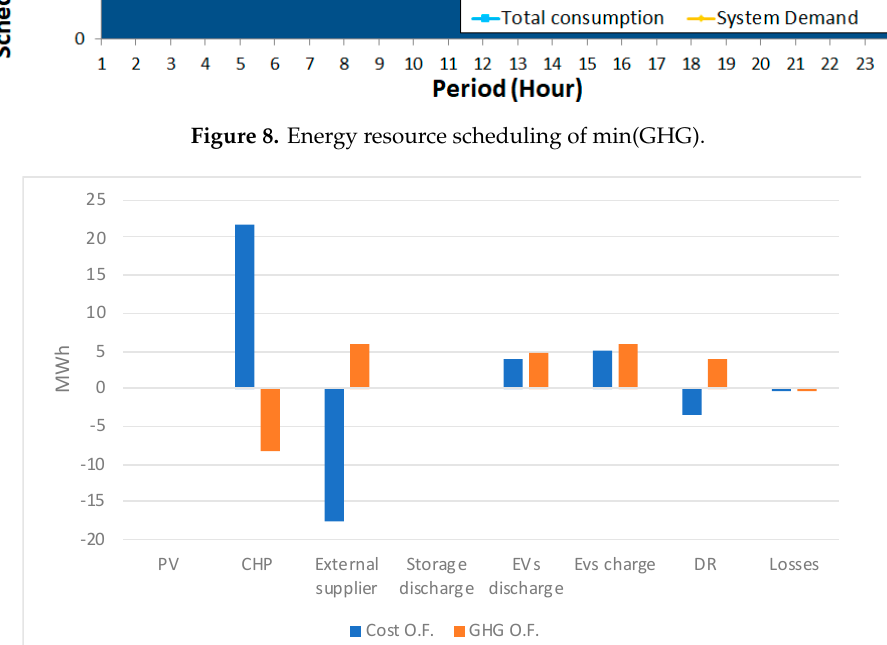
Figure 9. Resources scheduling differences for min(Cost)/min(GHG) in relation to min(Cost, GHG).